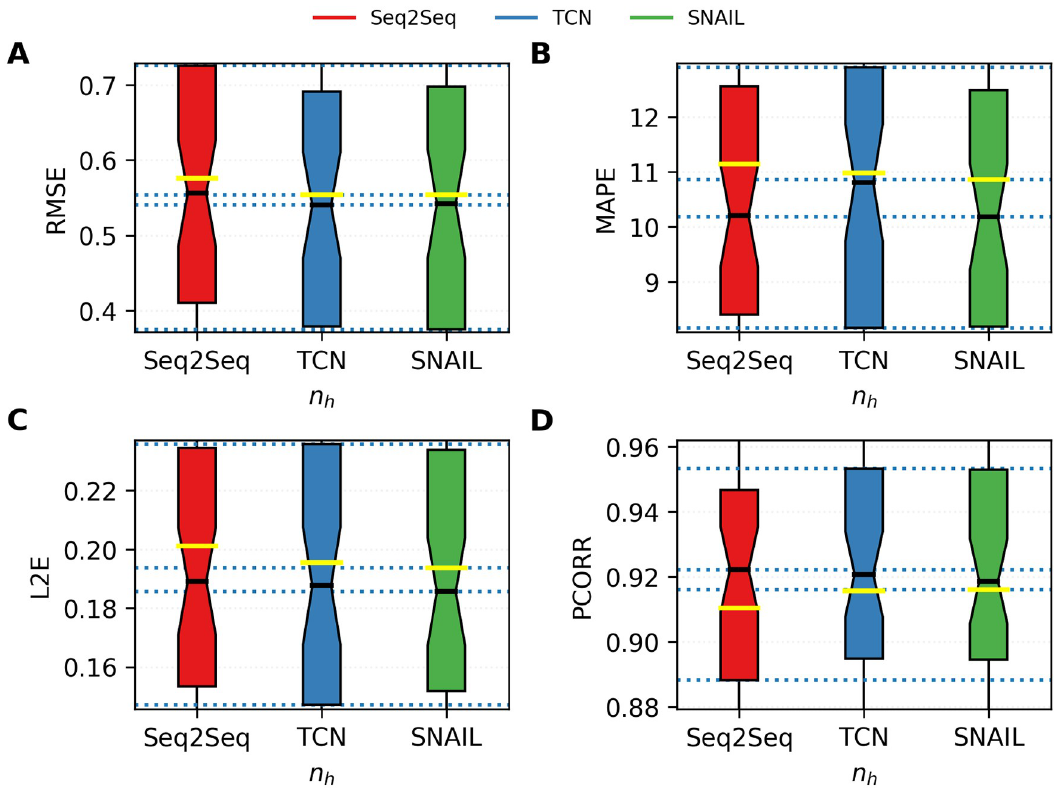
Fig 13. The boxplots of all four performance metrics measured by using Seq2Seq, TCN, and SNAIL. A. RMSE, B. MAPE, C. L2E, and D. PCORR. The IQRs of the boxplots are excerpted from Fig 12. and the predictions in mean-square error, the models are consistently ranked in RMSE and L2E. Since MAPE is a closely related error metric with MSE, the ranks of the models are also shown to be consistent over 49 states. As opposed to these three measures, for PCORR, the test statistic is 9.837 and the p -value is 0.007. This result suggests that the models are not consis- tently ranked on the error metric that the models are not directly minimized for.